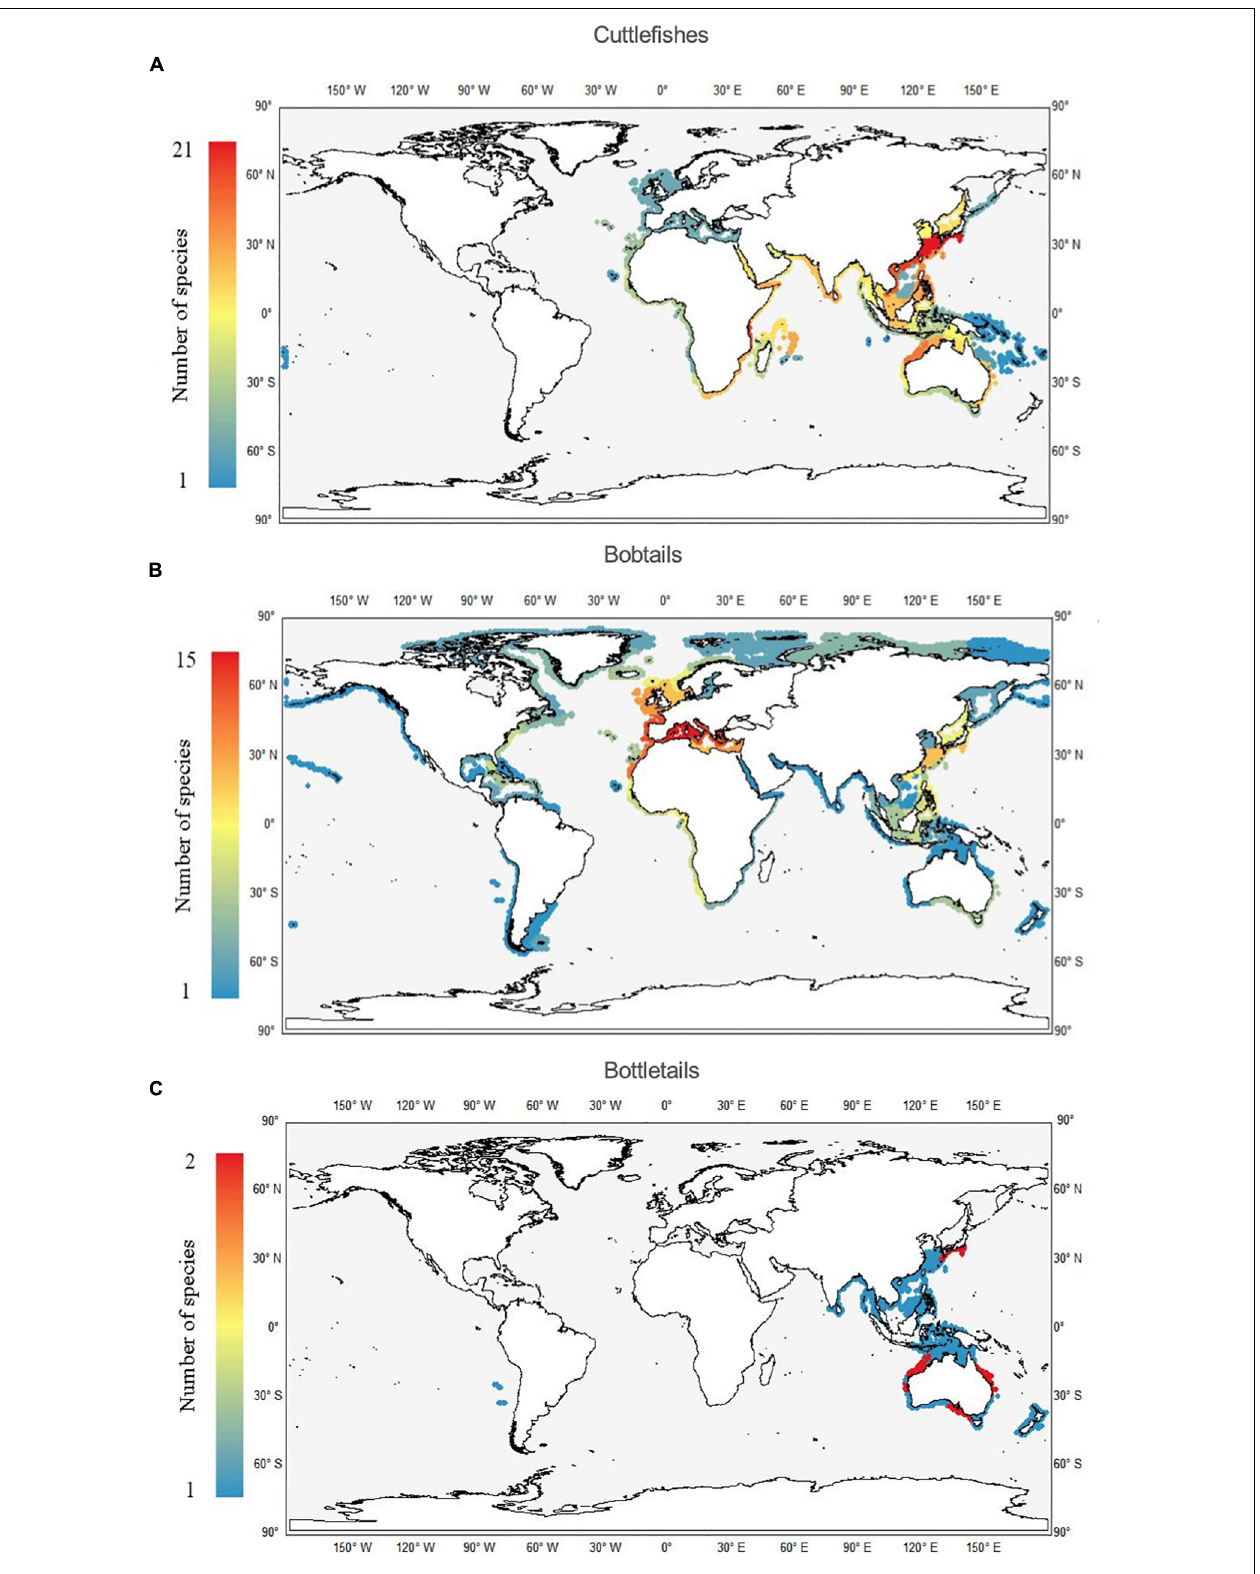
FIGURE 5 | Worldwide richness (number of species per ecoregion) patterns of cuttlefishes (Family Sepiidae; A ), bobtails (Family Sepiolidae; B ), and bottletails (Family Sepiadariidae; C ).